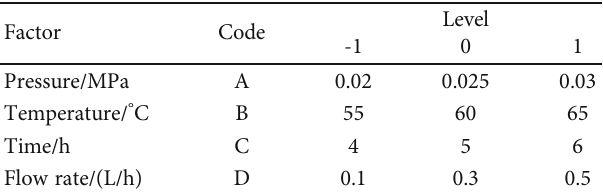
Table 1: The factor levels and coding values of the Box-Behnken design of wet steam enrichment.